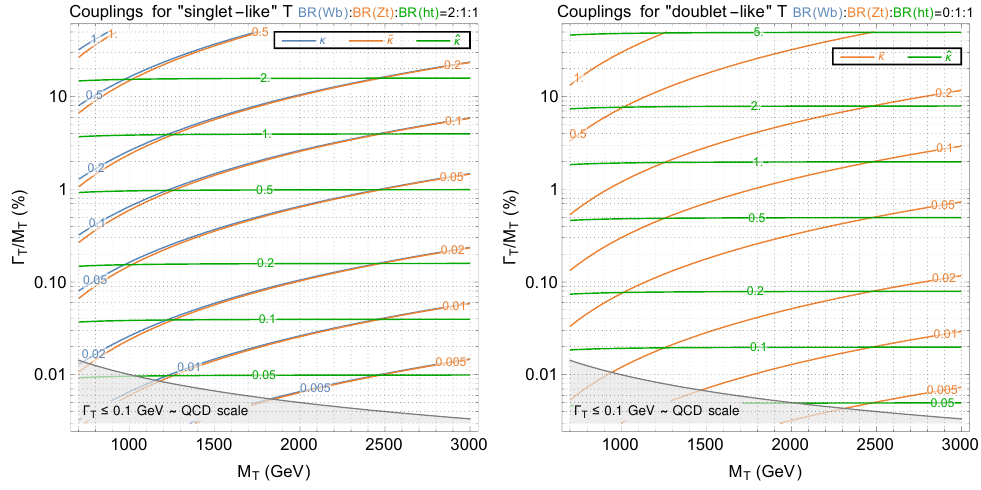
Figure 9 . Values of the couplings which saturate the values of the total width of the T VLQ and reproduce the asymptotic relations satisfied by the VLQ branching ratios. We consider a “singlet-like” T (left), i.e. BR ( Wb ) :BR ( Zt ) :BR ( ht ) = 2 : 1 : 1 , and a “doublet-like” T (right), i.e. BR ( Wb ) :BR ( Zt ) :BR ( ht ) = 0:1:1 . The couplings κ , ˜ κ , ˆ κ refer respectively to the coupling of Wb , Zt and ht with the VLQ T . As the partial widths depend on the couplings squared, the results above apply to the absolute values of the